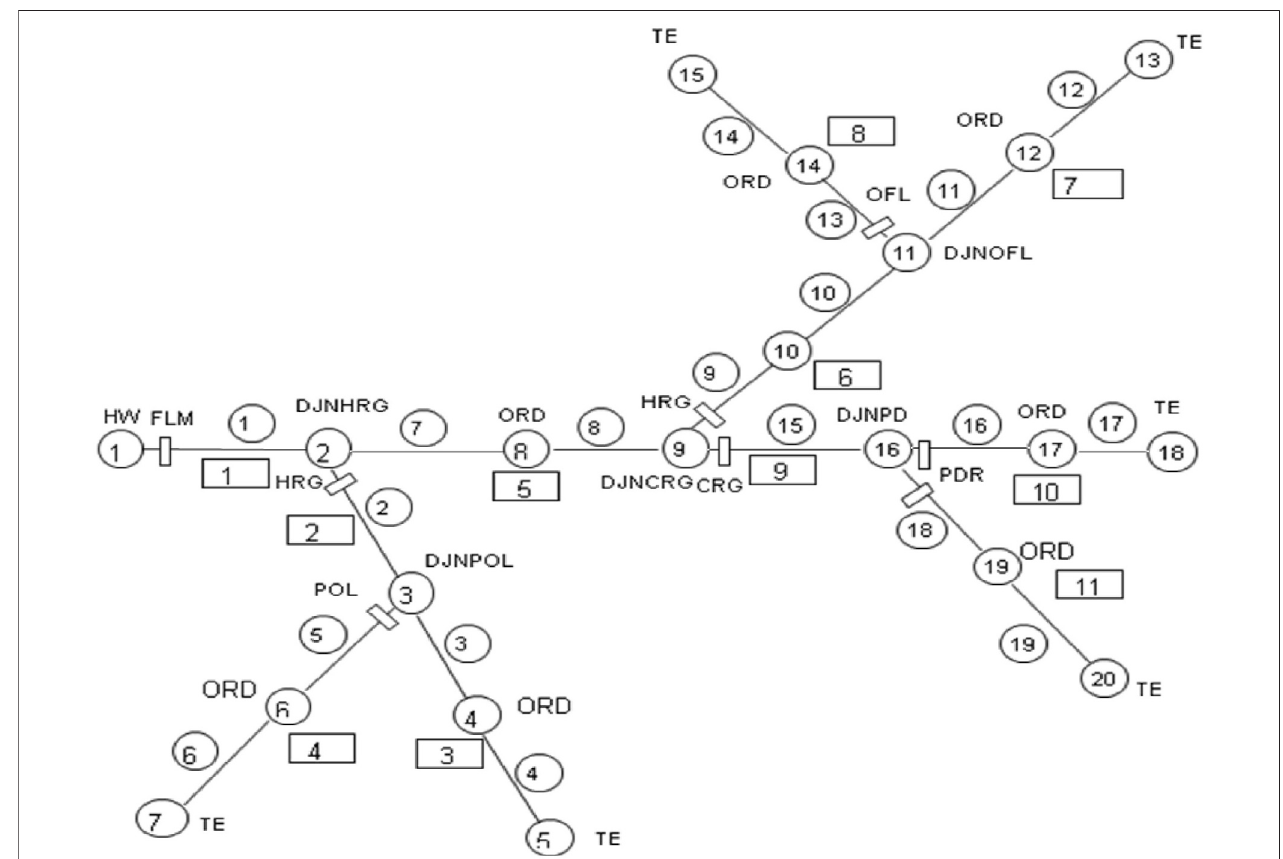
FIGURE 2 | Example